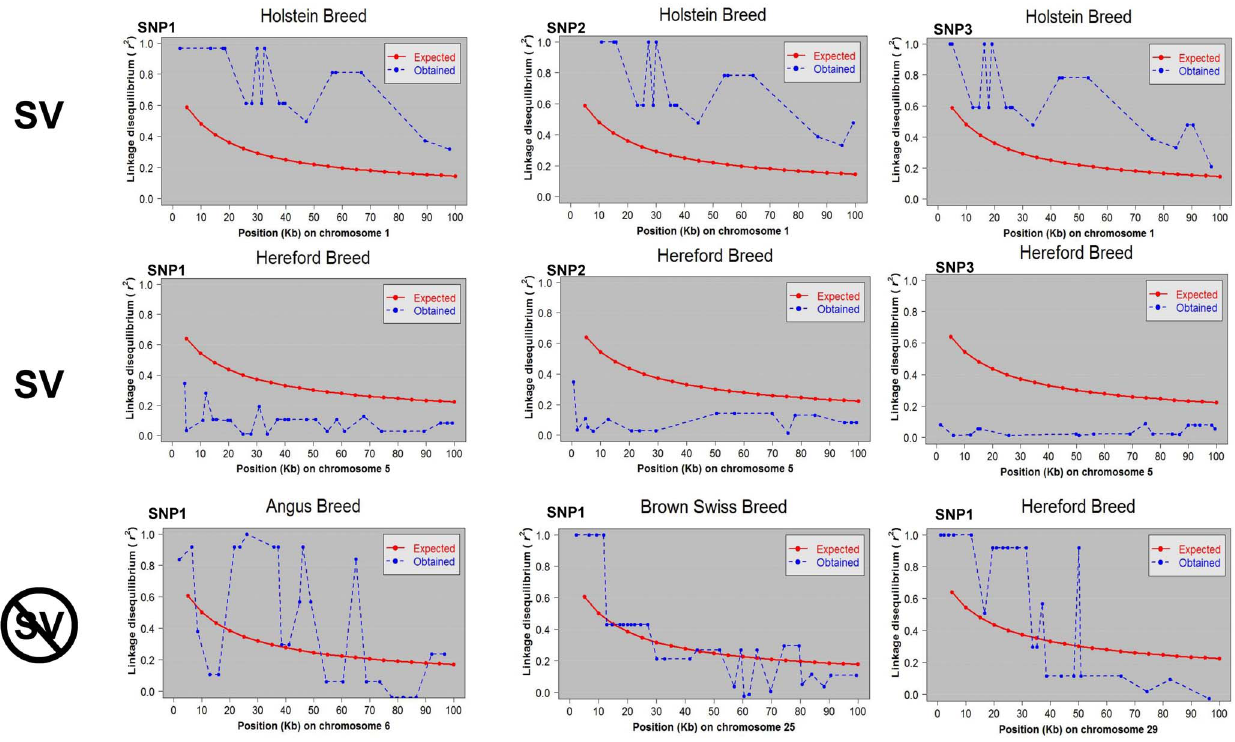
Figure 3. Structural Variation. Two samples declared as structural variations and one declared as containing no structural variation. Red line plots the expected LD. Blue line plots the actual LD between the first SNP and all its neighbors. At the top, three adjacent SNPs are inspected for LD with their neighbor SNPs in a range of 100kb, to the right. For the three SNPs, LD values are bigger than their expected LD mean and were declared significant after multiple testing corrections. In the middle, an example where the LD is smaller than expected LD mean, and as the previous example they were declared significant after correction. At the bottom, an example declared as no structural variation because LD for some of the SNP pairs alternate from being bigger than to smaller than their expected LD